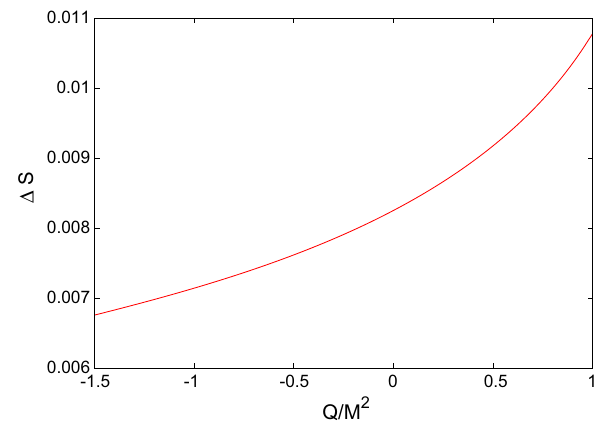
Fig. 7 Parameter regions Δ S vs Q for the bound orbits